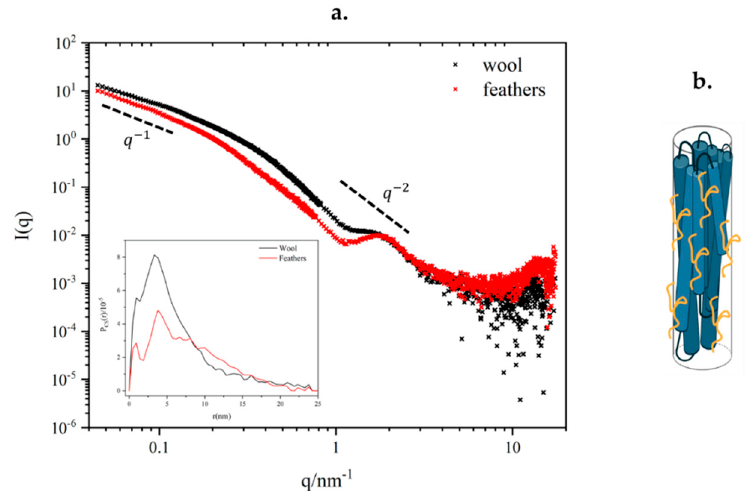
Figure 10. ( a ) Comparison between scattering curve of keratin extracted from wool (in black) and feathers (in red), in the inset figure, the Fourier transform of the scattering intensity; ( b ) sketch of the hypothesized fibers, which represents the possible aggregation of the smaller fibers in a bigger one; in yellow, the unfolded protein surfacing is reported.